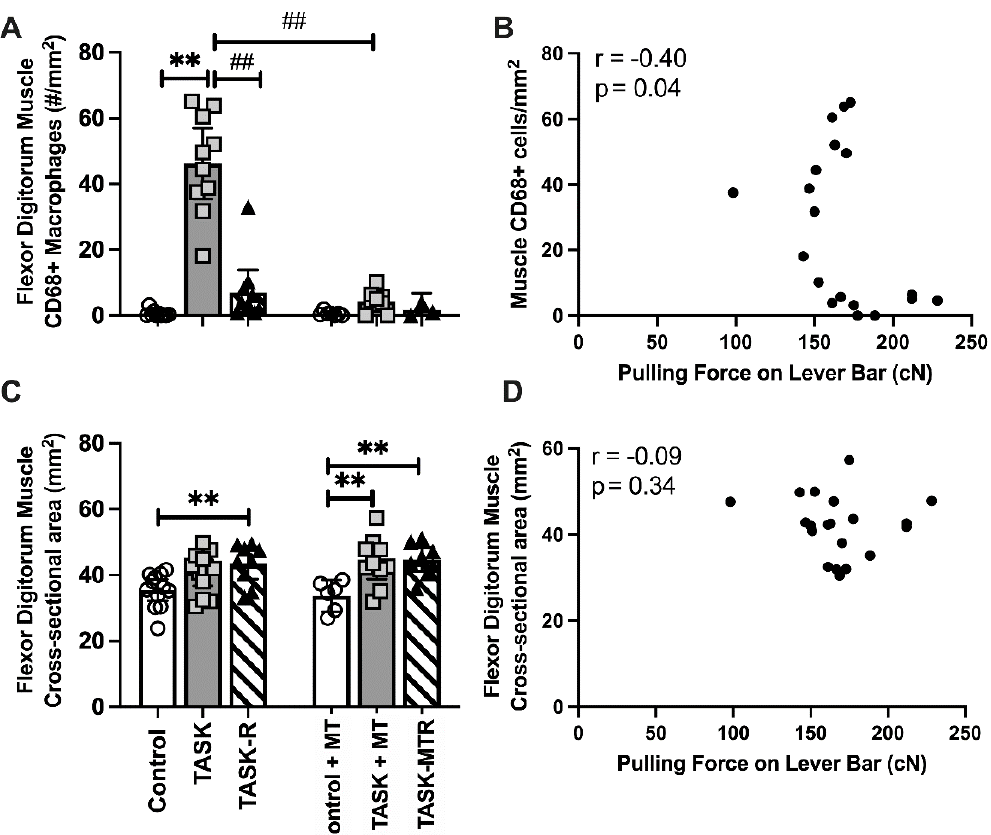
Figure 7. Assays of flexor digitorum muscle and Pearson’s correlations. ( A ) Number (#) of CD68 immunopositive macrophages in muscle. ( B ) Pearson’s correlation between # CD68+ cells in muscle and mean pulling force during the final two weeks of task performance. ( C ) Cross-section area (CSA) of flexor digitorum muscle at its widest point in mid-forearm. ( D ) Pearson’s correlation between the muscle CSA and mean pulling force during the final two weeks of task performance. Mean ± 95% confidence intervals (CIs) shown. Abbreviations: control rats (Control); 12-week TASK rats (TASK); TASK rats that rested for 6 weeks after task cessation (TASK-R); control rats that received manual therapy for 12 weeks (Control+MT); TASK rats that simultaneously received manual therapy for 12 weeks (TASK+MT); TASK rats that rested for 6 weeks after task cessation while receiving manual therapy treatment of their upper limbs three times per week (TASK-MTR). ##: p < 0.01, compared to the TASK group; **: p < 0.01, compared between groups as